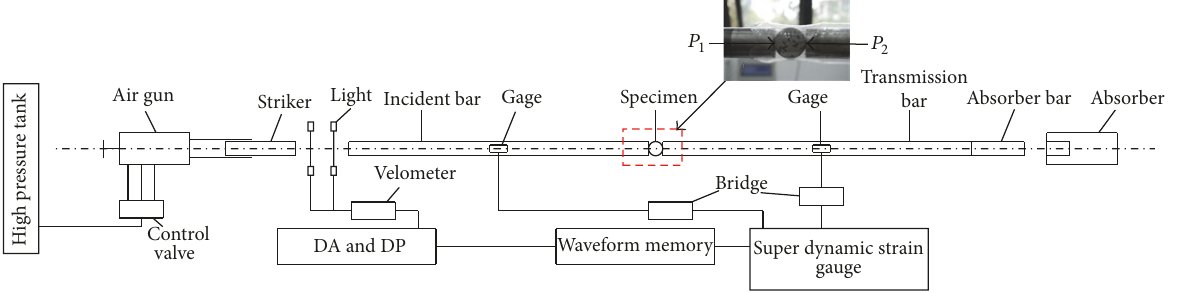
Figure 1: Split Hopkinson Pressure Bar (SHPB) system.